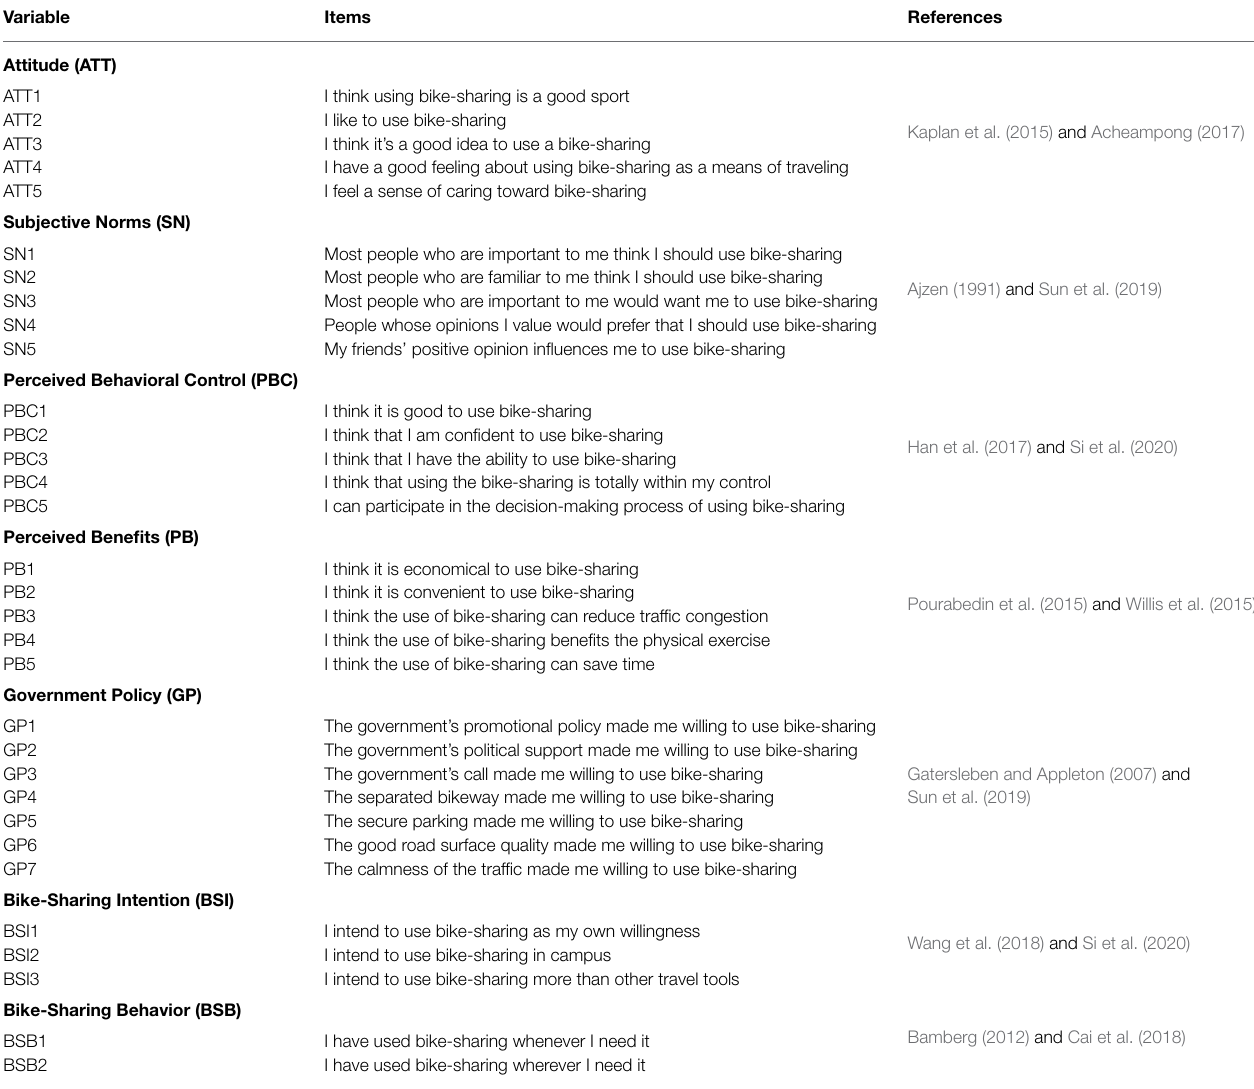
TABLE 2 | Survey items related to behavioral intention toward the sustainable bike-sharing usage. Variable